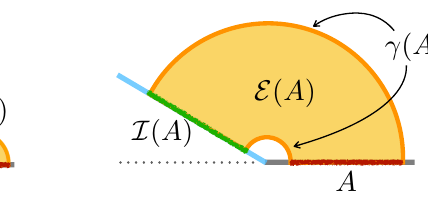
. The asymptotic boundary Σ is 3